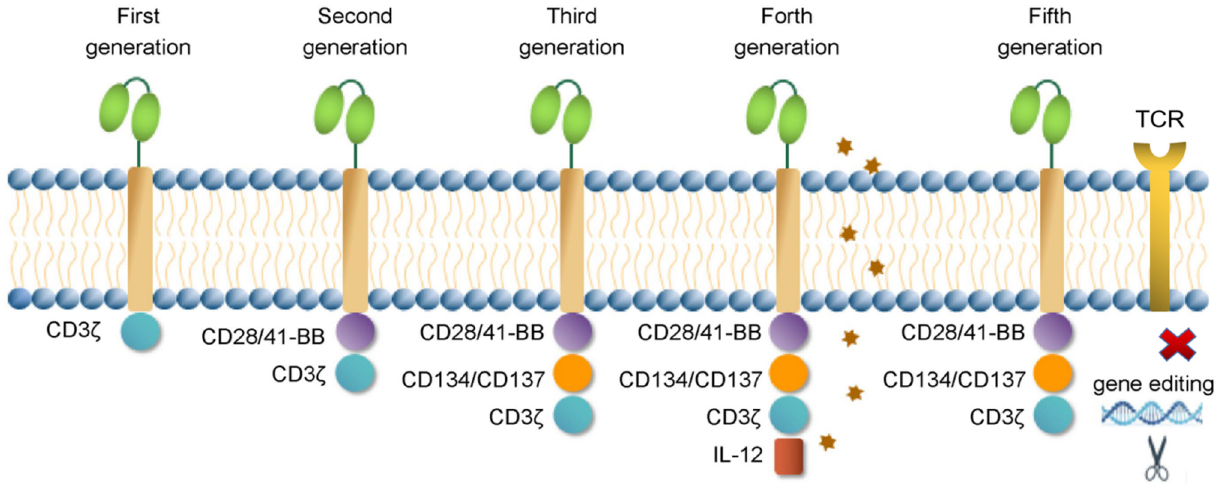
Figure 1. Structures of CAR-T.